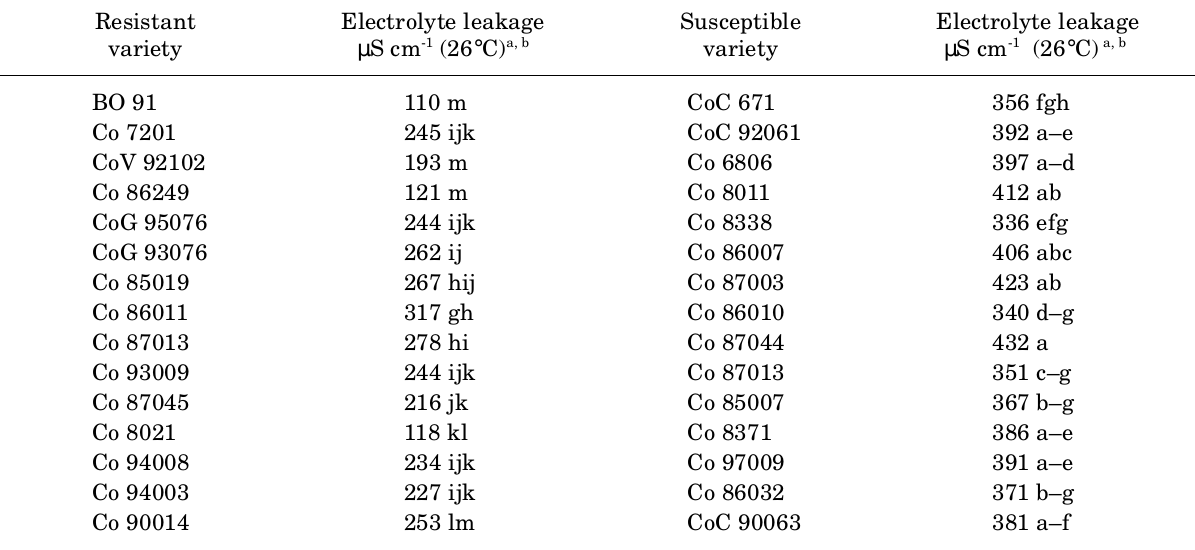
Table 1. Electrolyte leakage from the leaf tissues of various sugarcane varieties in response to treatment with red- rot